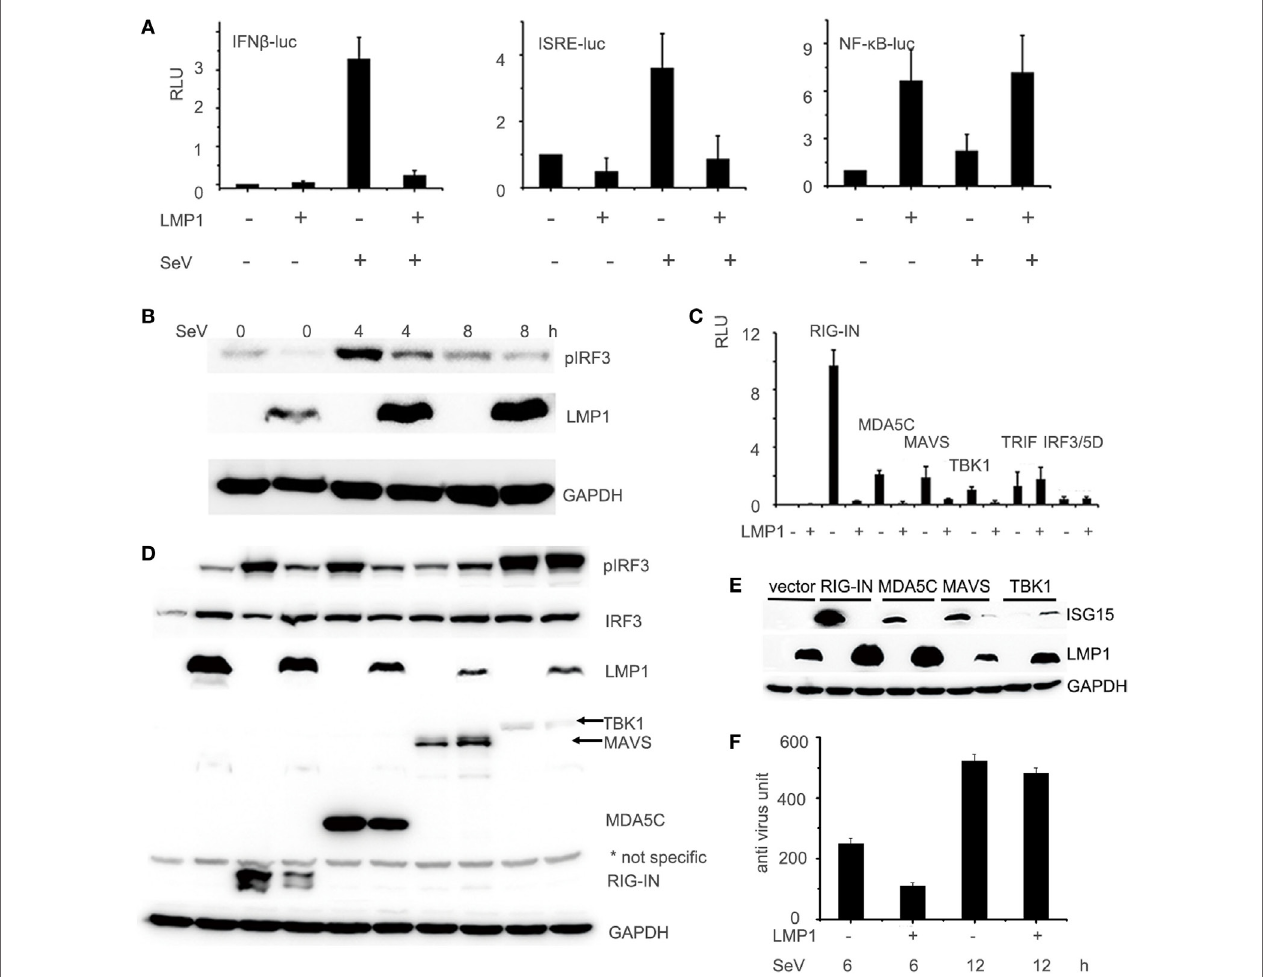
FigUre 1 | LMP1-inhibits SeV and RIG-I-mediated transactivation of IFN- β . (a) 293T cells were transfected with 0.1 µg IFN- β , ISRE, or NF- κ B luciferase reporter together with 0.1 µg pCMV- β -gal (as internal control), and 0.5 µg pCMV-Myc-LMP1 or empty vector. 24 h after transfection, 293T cells were challenged with SeV for 12 h. Luciferase activity was analyzed at 12 h post-infection and relative luciferase activity (RLU) (relative to the basal level of reporter gene in the presensence of pCMV-Myc vector after nomalization with co-transfected β -gal activity) was determined compared to uninfection control. The data are shown as the mean ± SD and are representative of one of three independent experiments ( n = 3). Results are representative of at least three experiments run in triplicates. (B) CNE2 cells were transfected with pCMV-LMP1, after 24 h transfection, infected by SeV for 4 and 8 h, phosphorylated IRF3 of CNE2 cells was detected by Western blot. (c) 293T cells were transfected with 0.5 µg pCMV-LMP1 (vector as control), 0.25 µg signal molecules 0.1 µg IFN- β and 0.1 µg β -gal. Luciferase activity was analyzed after 24 h post transfection. (D) 293T cells were transfected with 0.25 µg signal molecules, pEGFP-IRF3, and pCMV-LMP1 (vector as control). 24 h post transfection, phosphorylated IRF3 was detected by Western blot. (e) 293T cells were transfected with 0.25 µg signaling molecules and pCMV-LMP1 (vector as control). 24 h post transfection, endogenously induction of ISG15 was detected by Western blot. (F) 293T cells were transfected with 1 µg pCMV-LMP1 (vector as control) per well in 6-well plates, stimulated with SeV (MOI = 1) for 6 and 12 h, supernatants were collected to test IFNs antivirus titers. IFNs activity was determined by IFN assays: calculating the protection of the WISH cells against the cytopathic effects caused by